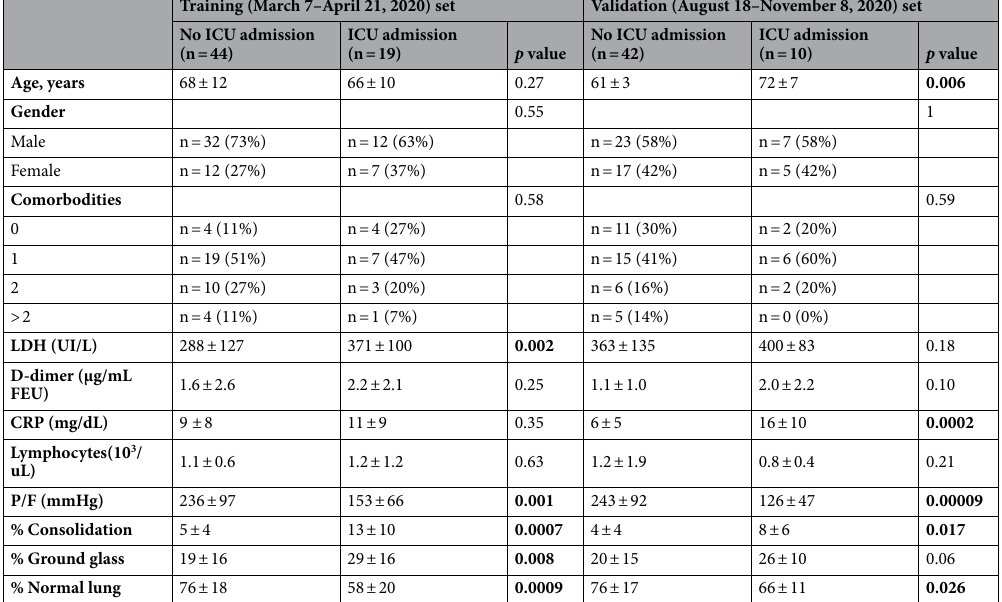
Table 1. Clinical, blood laboratory, arterial gas analyses and CT results in patients with COVID-19 pneumonia. Continuous values are expressed as mean ± standard deviation. P/F = ratio between the arterial partial pressure of oxygen [PaO 2 ] measured (in mmHg) by blood gas analysis and fraction of inspired oxygen